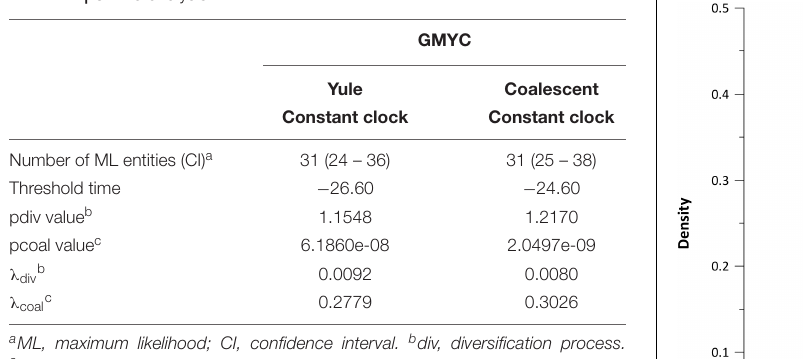
TABLE 1 | GMYC analysis.